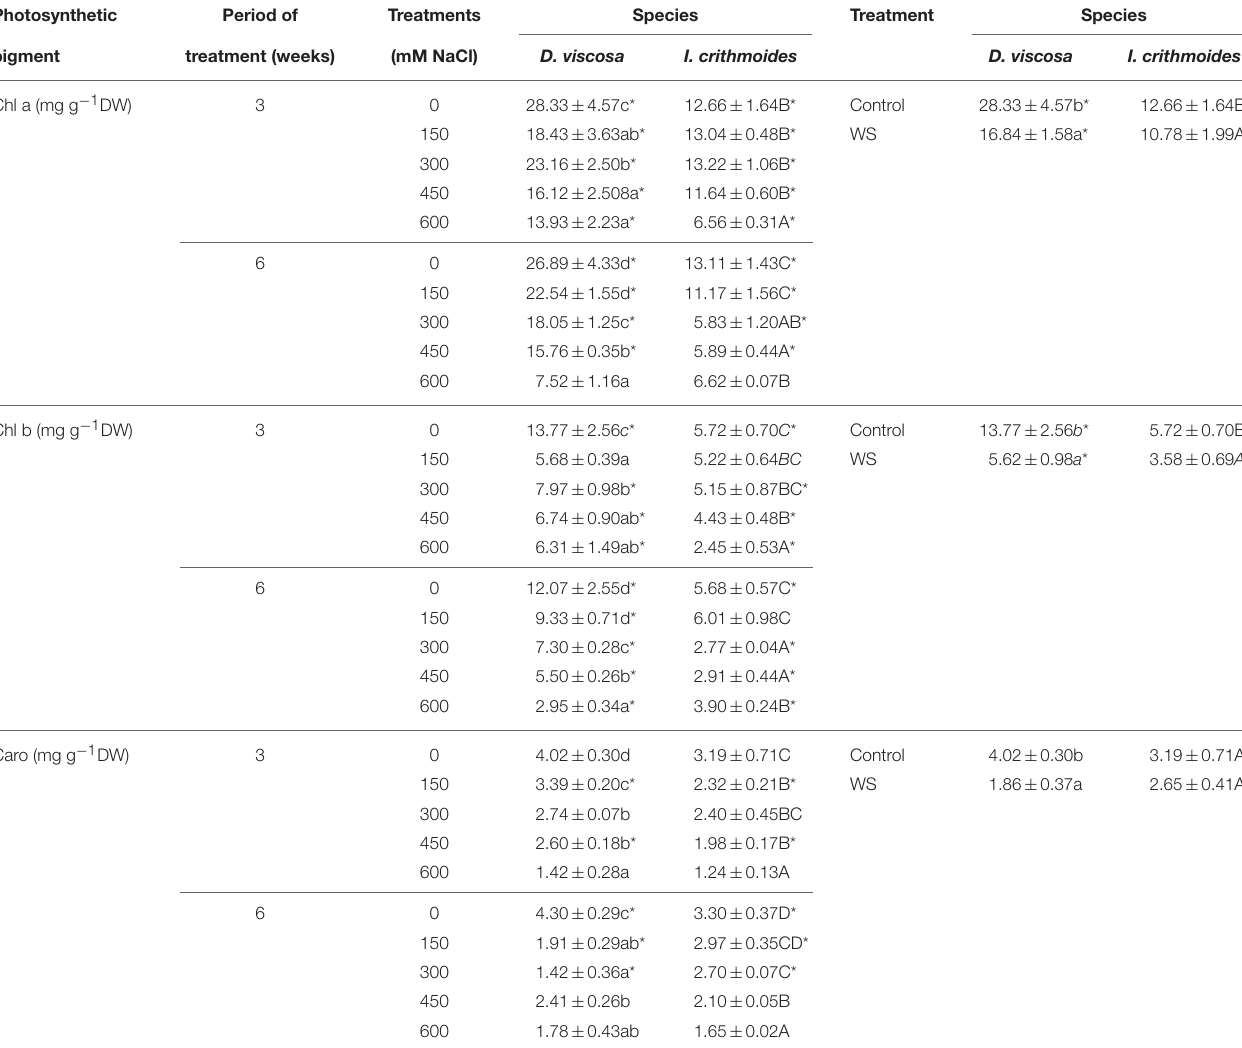
TABLE 1 | Photosynthetic pigments in leaves of salt-treated and water-stressed D. viscosa and I. crithmoides plants. Photosynthetic Period of Treatments Species Treatment Species pigment treatment (weeks) (mM